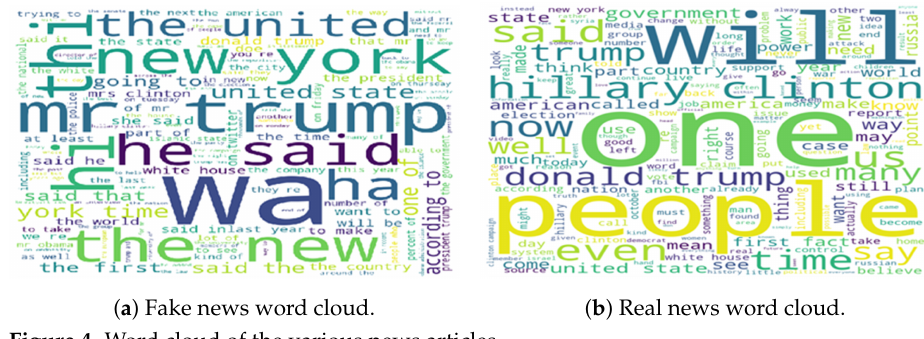
Figure 4. Word cloud of the various news